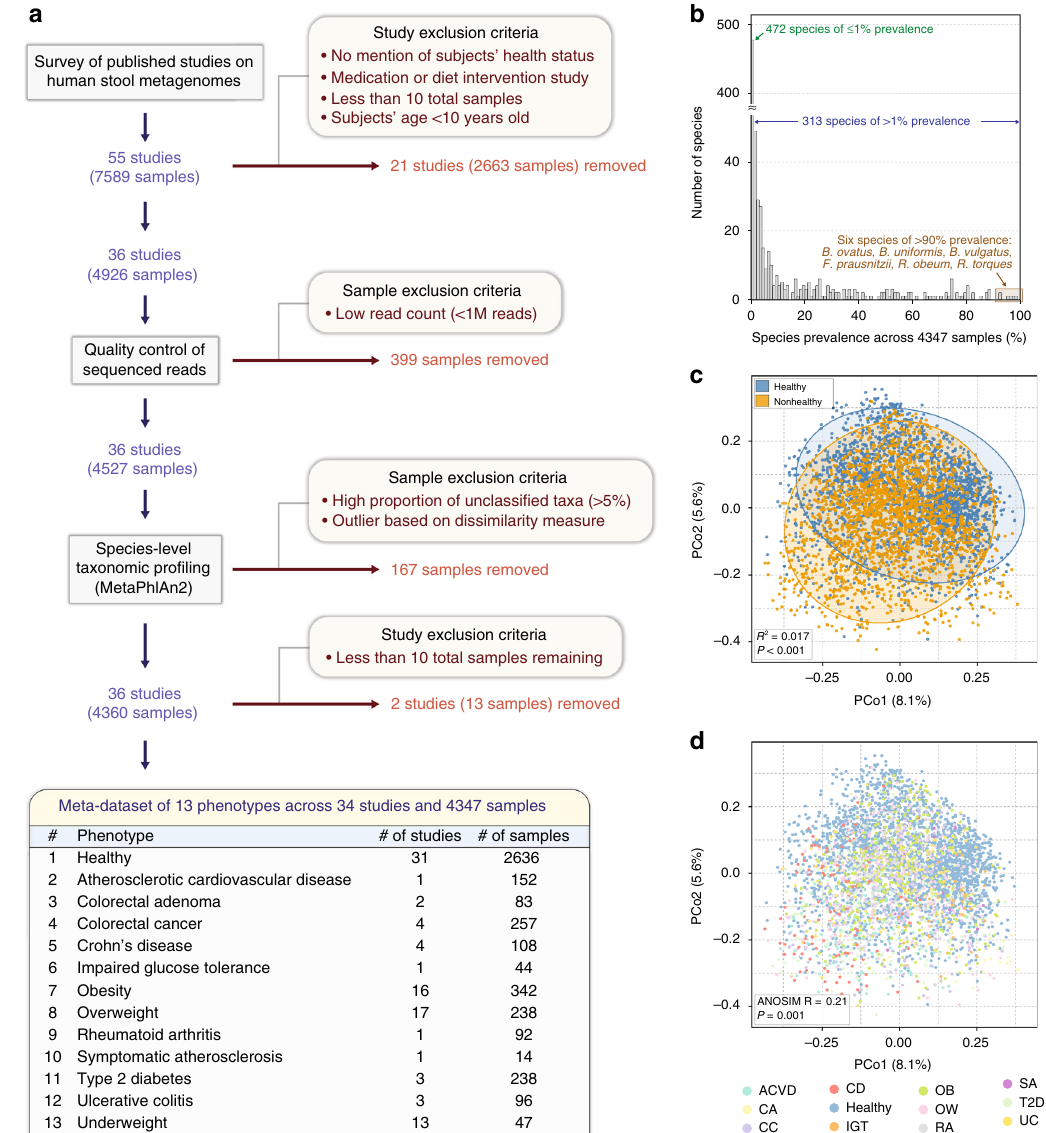
Fig. 1 Multi-study integration of human stool metagenomes leads to a meta-dataset of healthy and nonhealthy gut microbiomes. a Schematic overview. A survey was conducted in PubMed and Google Scholar to search for published studies with publicly available human stool metagenome (gut microbiome) samples from healthy and nonhealthy individuals. The initial collection of stool metagenomes consisted of 7589 samples from 55 independent studies. All samples (.fastq fi les) were downloaded and reprocessed uniformly using identical bioinformatics methods. After quality control of sequenced reads, species-level taxonomic pro fi ling was then performed. Studies and metagenome samples were removed based on several exclusion criterias. Finally, a total of 4347 samples (2636 and 1711 metagenomes from healthy and nonhealthy individuals, respectively) from 34 studies ranging across healthy and 12 nonhealthy phenotypes were assembled into a meta-dataset for downstream analyses. b Distribution of microbial species ’ prevalence across the 4347 stool metagenome samples in the meta-dataset. After removing viruses, unknown/unclassi fi ed species-level entities, and rarely observed species (i.e., detected <1% of all samples), 313 species remained for further analyses. c Principal coordinates analysis (PCoA) ordination plot based on Bray – Curtis distances shows that healthy (blue; n = 2636) and nonhealthy (orange; n = 1711) groups have signi fi cantly different distributions of gut microbiome pro fi les according to PERMANOVA ( R 2 = 0.017, P < 0.001) after adjusting for each sample ’ s study origin. Each point corresponds to a sample. Ellipses correspond to 95% con fi dence regions. d In an identical PCoA plot, each color represents one of the 13 different phenotypes of health or disease. Among- and within- group dissimilarities differ only weakly (ANOSIM R = 0.21, P =